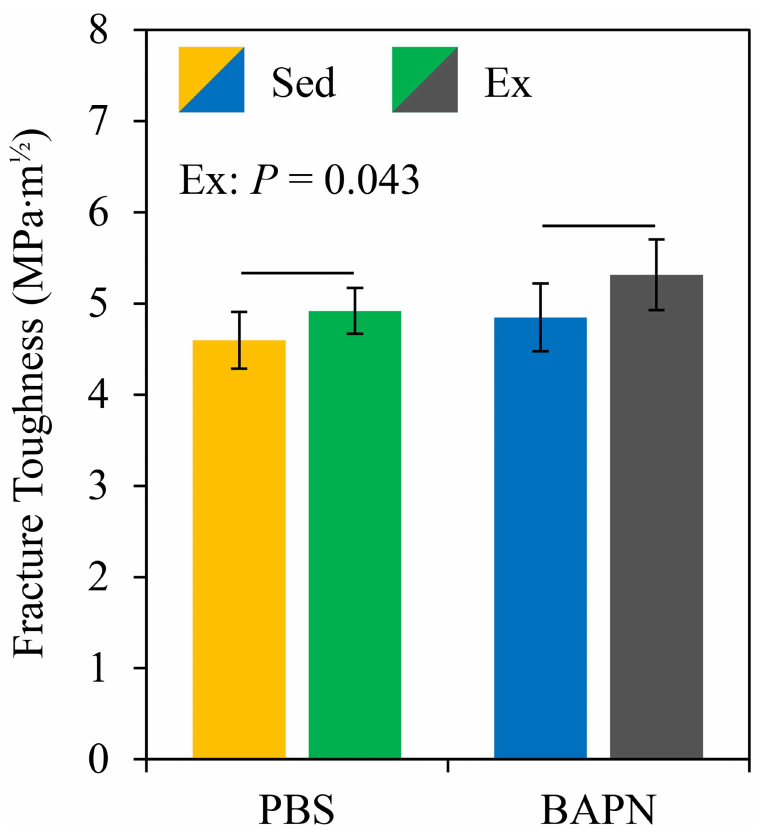
Fig 3. Exercise increased fracture toughness. Exercise improved the fracture instability K c for PBS and BAPN treated